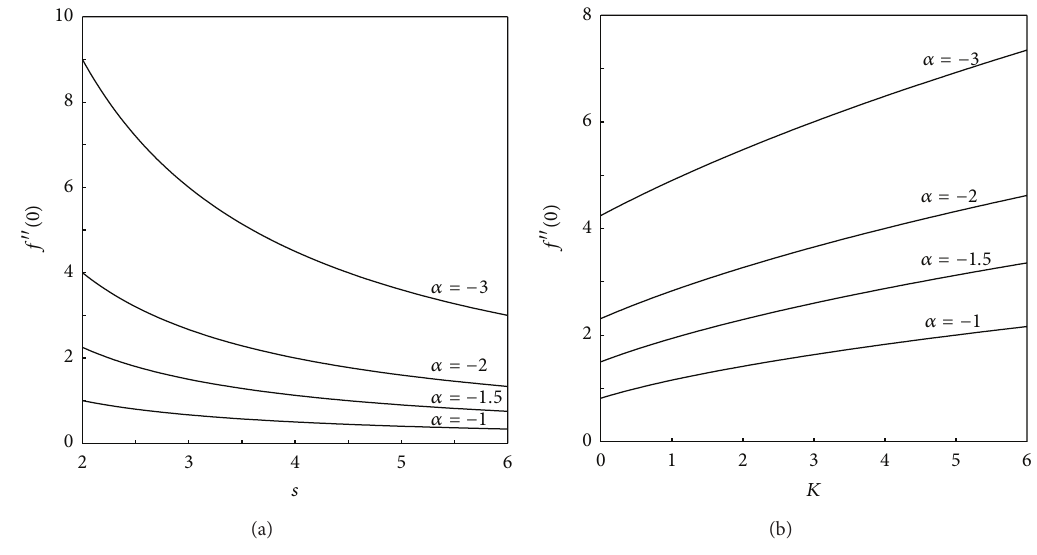
Figure 8: (a) Wall shear stress, 𝑓 󸀠󸀠 (0) with 𝑠 for various values of 𝛼 . (b) Wall shear stress, 𝑓 󸀠󸀠 (0) with 𝐾 for various values of 𝛼